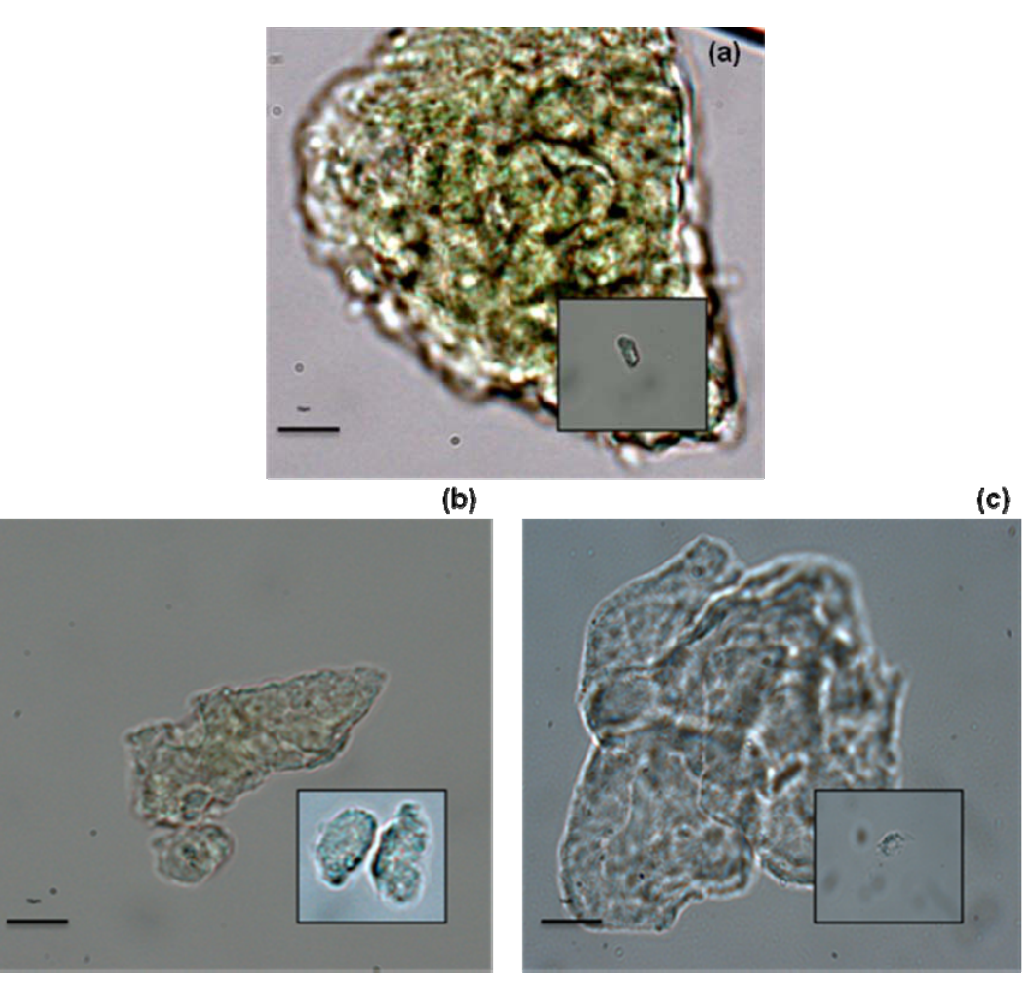
Figure 3. Microscopic observations of Chlorella vugaris ( a ) native microalgae (without extraction); ( b ) n -hexane extraction; ( c ) terpenes